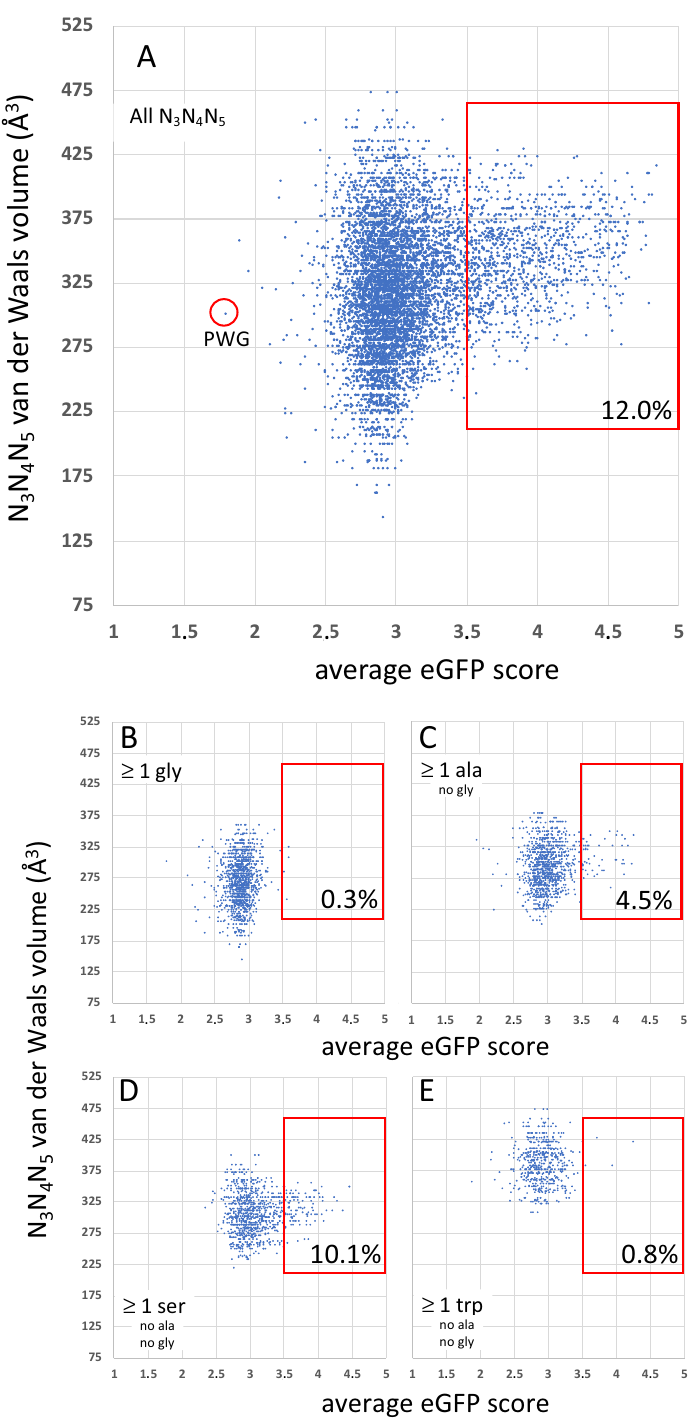
Figure 6. Van der Waals volume of N 3 –N 5 triplets as a function of average eGFP scores (see Fig. 5). Only triplets for which at least 5 independent eGFP scores were reported are included (Supplementary Data 3 from Ref. 3 ). ( A) Plot with all N 3 –N 5 triplets. ( B ) Plot for all triplets that include at least one glycine. ( C ) Plot for all triplets that include at least one alanine and no glycine. ( D ) Plot for all triplets that include at least one serine, without any glycine and alanine. ( E ) Plot for all triplets that include at least one tryptophan without any glycine and alanine. The fraction of eGFP scores equal or higher than 3.5 are highlighted on the